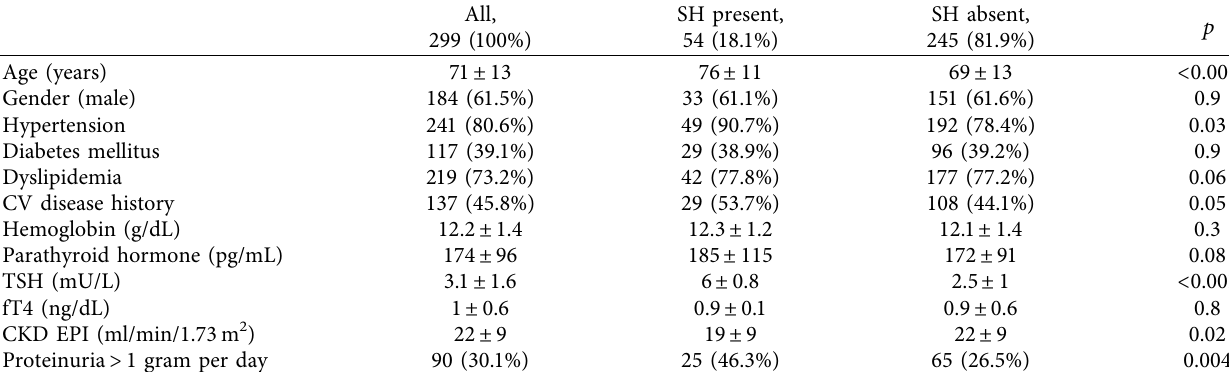
Table 1: Clinical characteristics of the study population.